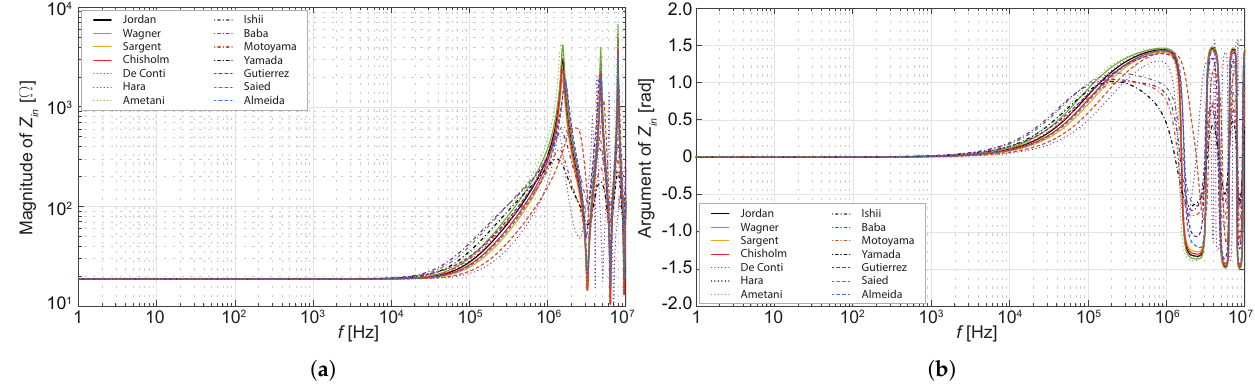
Figure 29. Input impedance Z in ( f ) seen at the top of tower (b) in Figure 16 over the soil with = 20, and Z gr ( f ) in Figure 19. ( a ) Magnitude of Z ρ g = 600 Ω m, (cid:101) r g